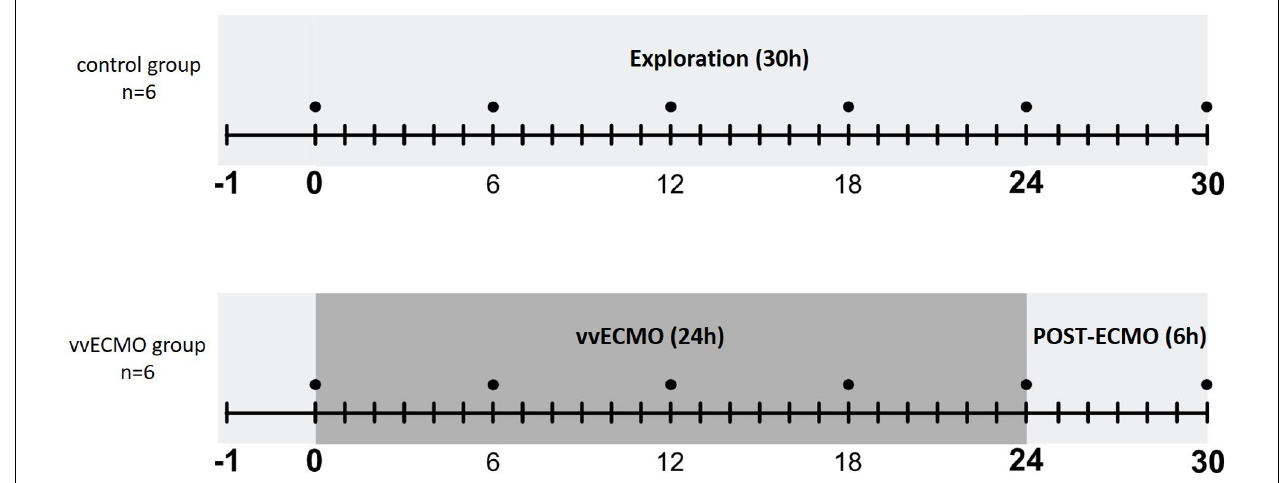
FIGURE 1 | Scheme of experimental